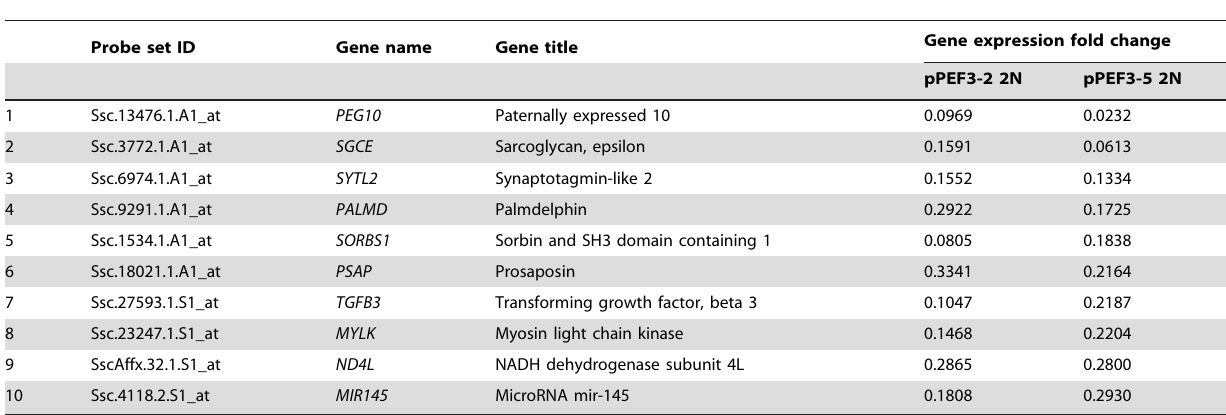
Table 5. Ten most downregulated genes in porcine parthenogenetic diploid fetal fibroblasts.